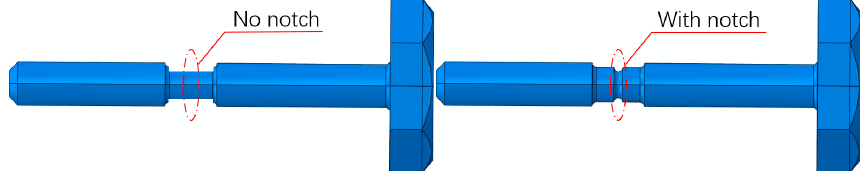
Figure 1. Three-dimensional model of bolt.